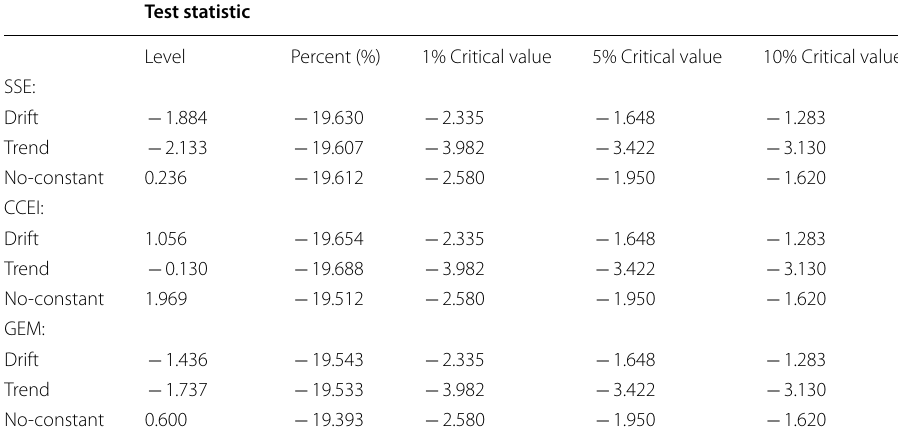
Table 7 Dickey–Fuller test for unit root